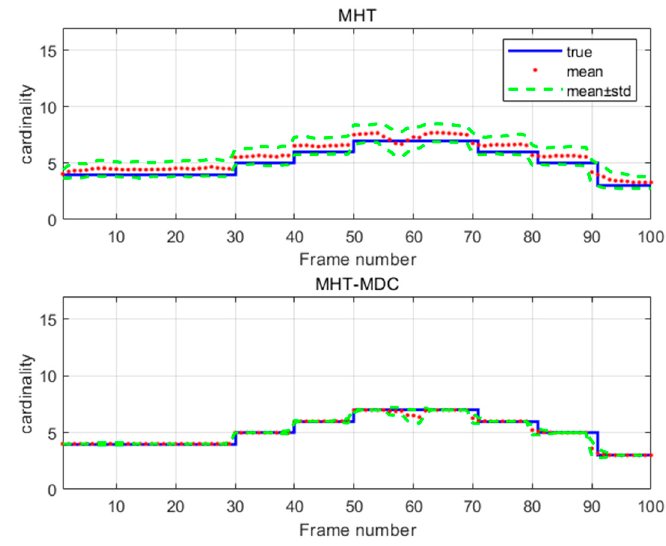
Figure 9. The optimal sub-pattern assignment (OSPA) distance of two algorithms in scenario 1.